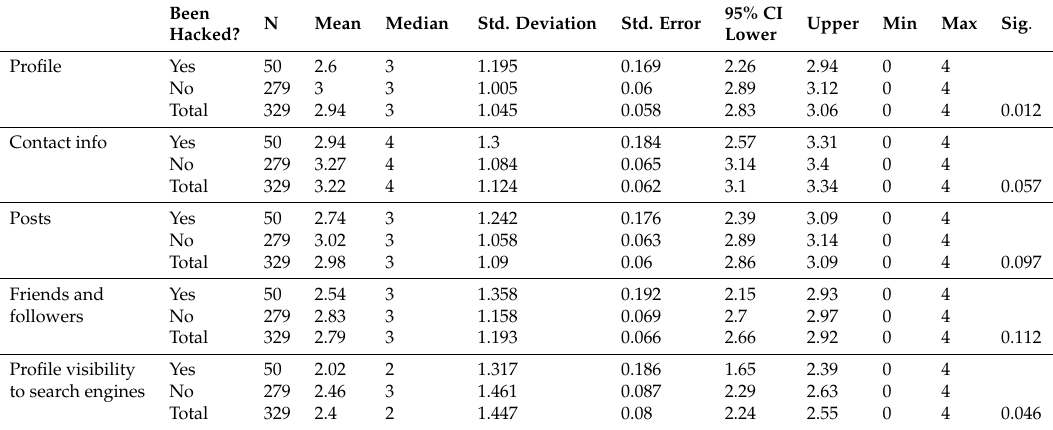
Figure 6. “I limit as much as possible who can see my ... on social media”, answering “1” means no limitation on visibility, “4” means strict limitation on visibility and “0” means I do not know. Table 11. Differences in privacy settings between sufferers of account hacking and the remaining sample. “I limit as much as possible who can see my ... on social